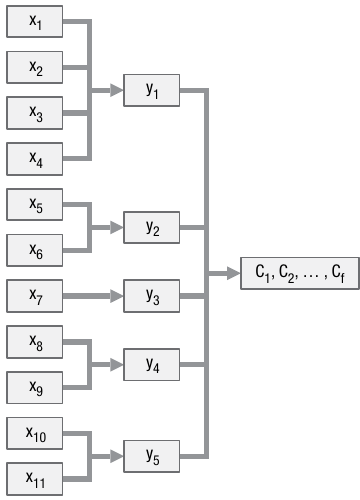
Fig. 2. The hierarchical multi-block PCA model